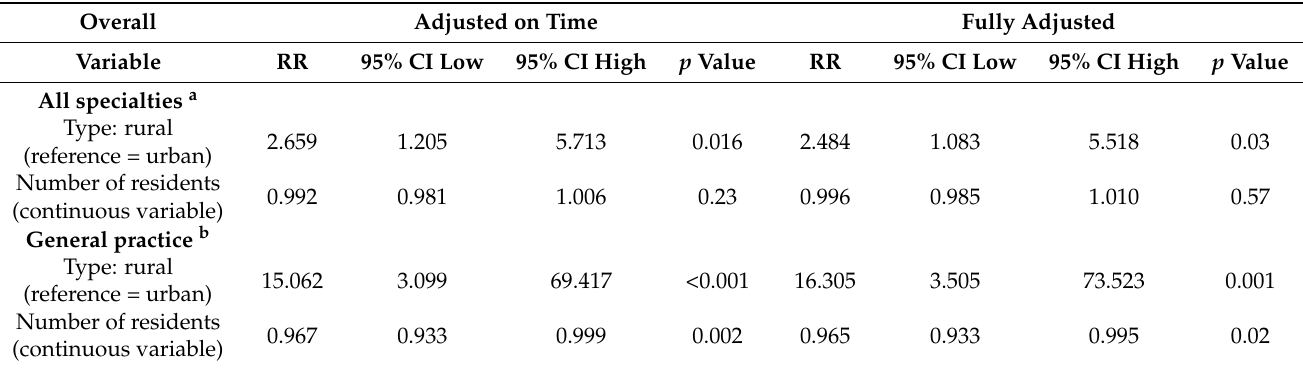
Table 3. Multivariate analysis with a negative binomial model evaluating the number of teleconsultations during aggregated 1-year periods with Troyes Hospital in France between 2018 and